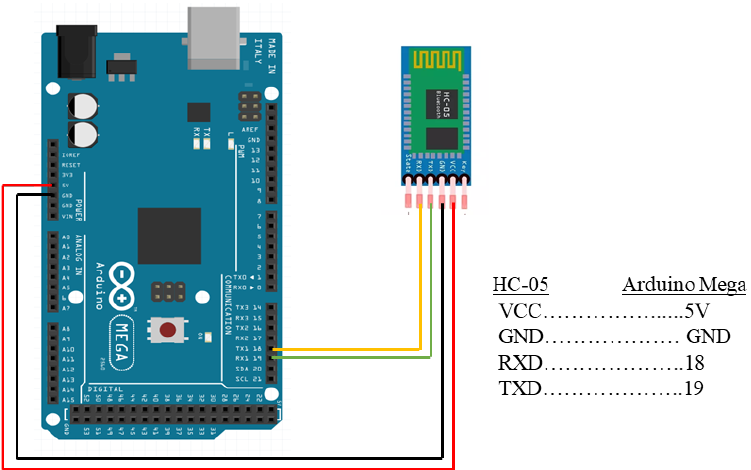
Figure 7. Connection diagram of HC-05 Bluetooth module with Arduino Mega.